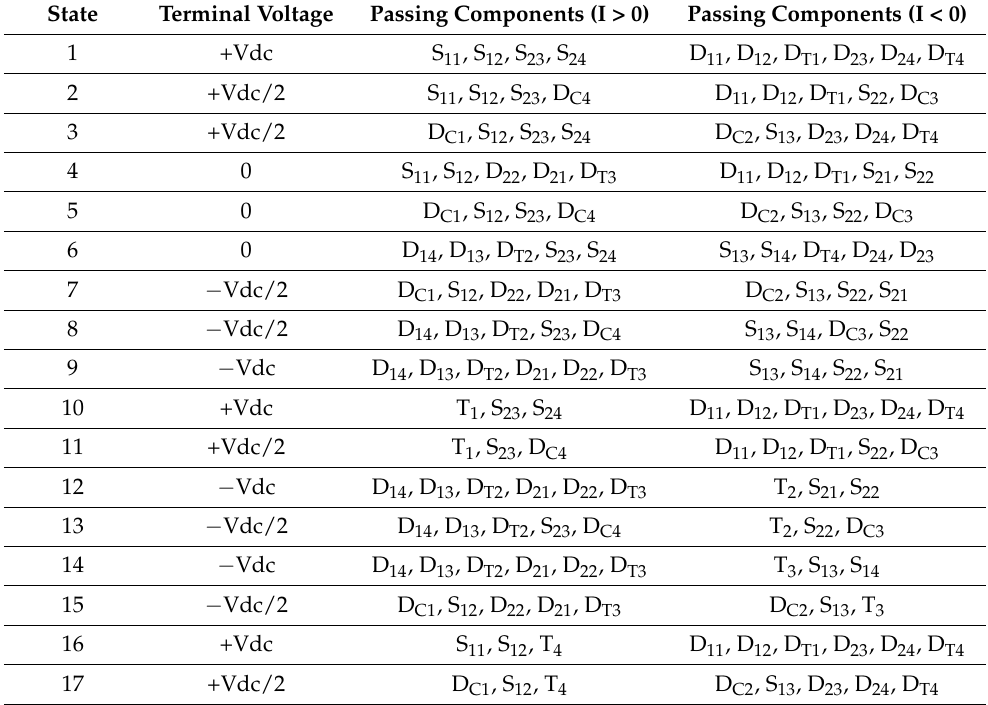
Table 2. Passing components corresponding to each switching state for positive and negative output currents in healthy (States 1 to 9) and fault-tolerant operation (States 10 to 17).